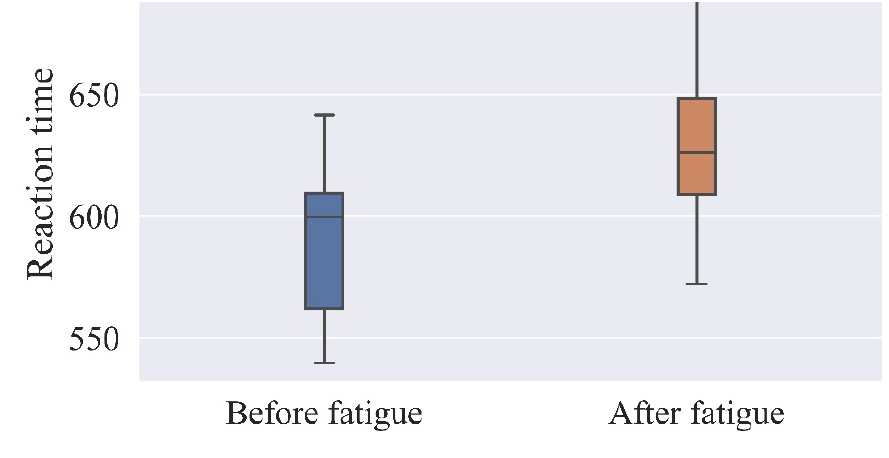
Table 5. Paired samples t -test results for reaction time.